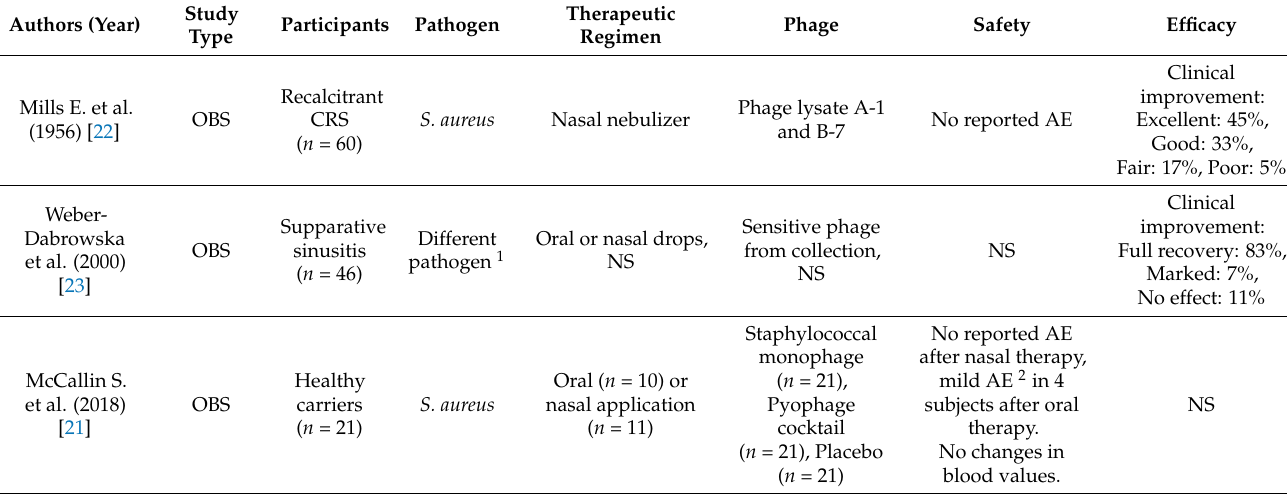
Table 4. Overview of clinical trials investigating the safety and efficacy of phages or phage-derived enzymes in the treatment of (recalcitrant)